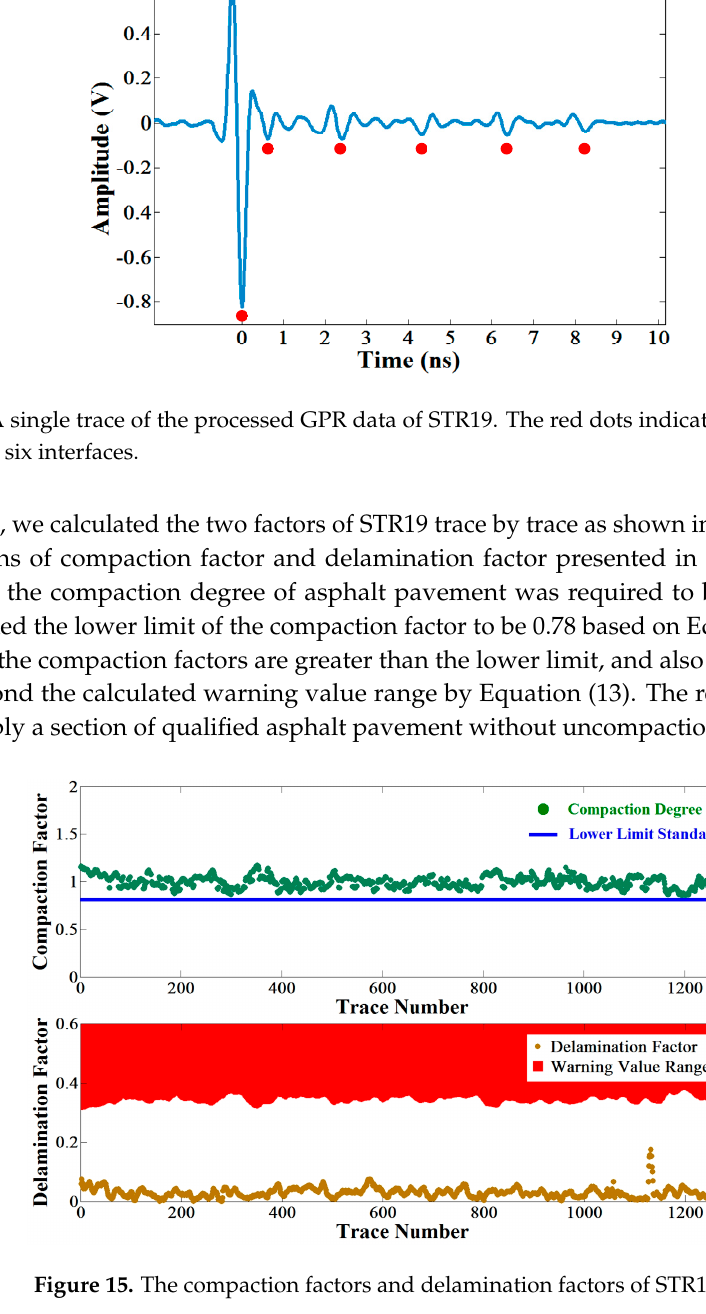
Figure 13. ( a ) The raw GPR data of STR 19; ( b ) The processed GPR data; ( c ) The underground layers of STR19.